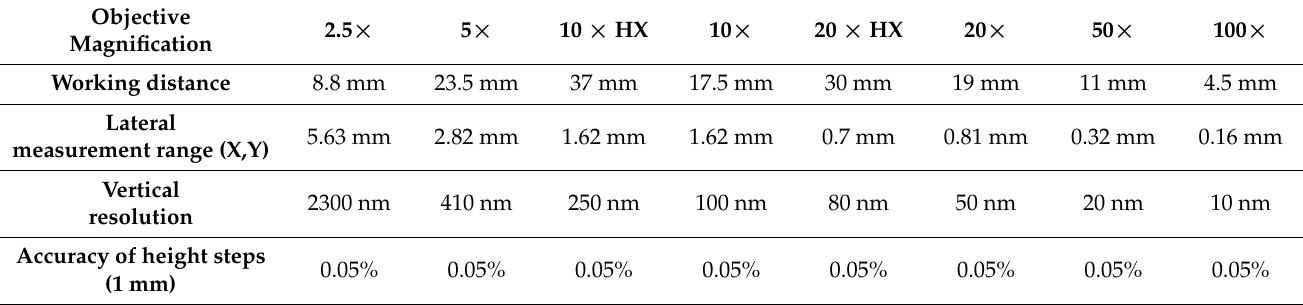
Table 2. Technical specification Alicona Infinite